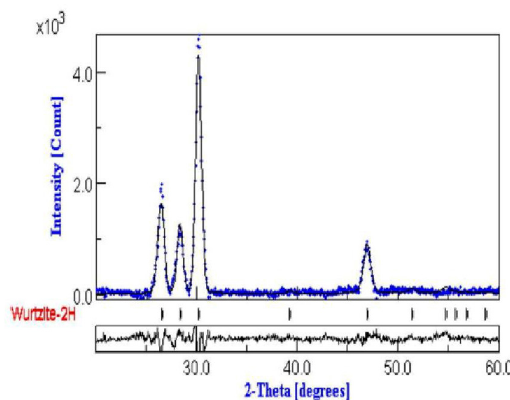
Figure 2: Reitveld output of ZnS [experimental (dotted) and fitted (continuous)].